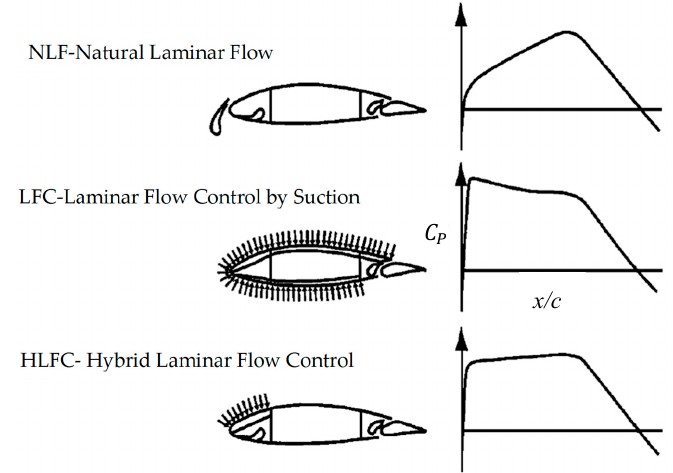
Figure 1. Schematic of natural laminar flow (NLF), laminar flow control (LFC) and hybrid laminar flow (HLFC) approaches for wing from [6].